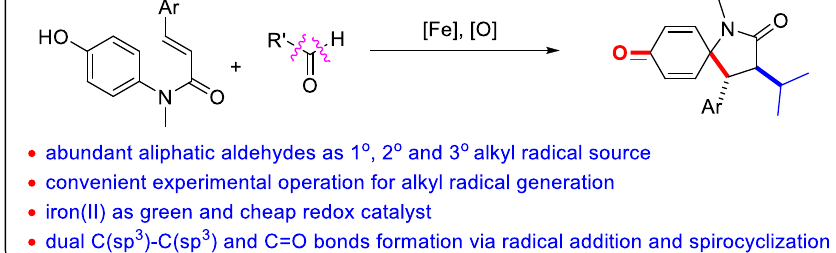
Scheme 1. Various radicals for the spirocyclization of N -aryl unsaturated amides.